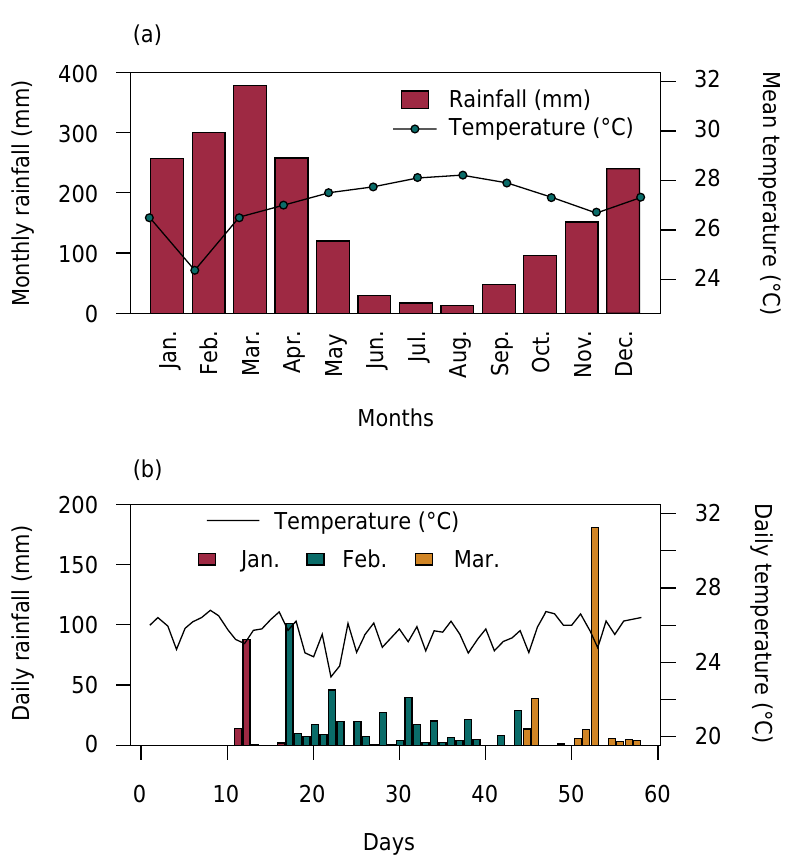
Figure 1. Climatological normal of Marabá-PA: 1981-2010 (a), with temperature distribution and precipitation during the data collection period (b). Source: Adapted from Inmet data